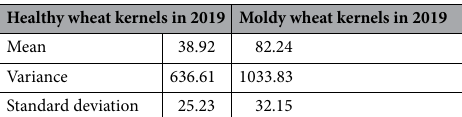
Table 1. Three statistic parameters of UWL data of two types of wheat subsamples.